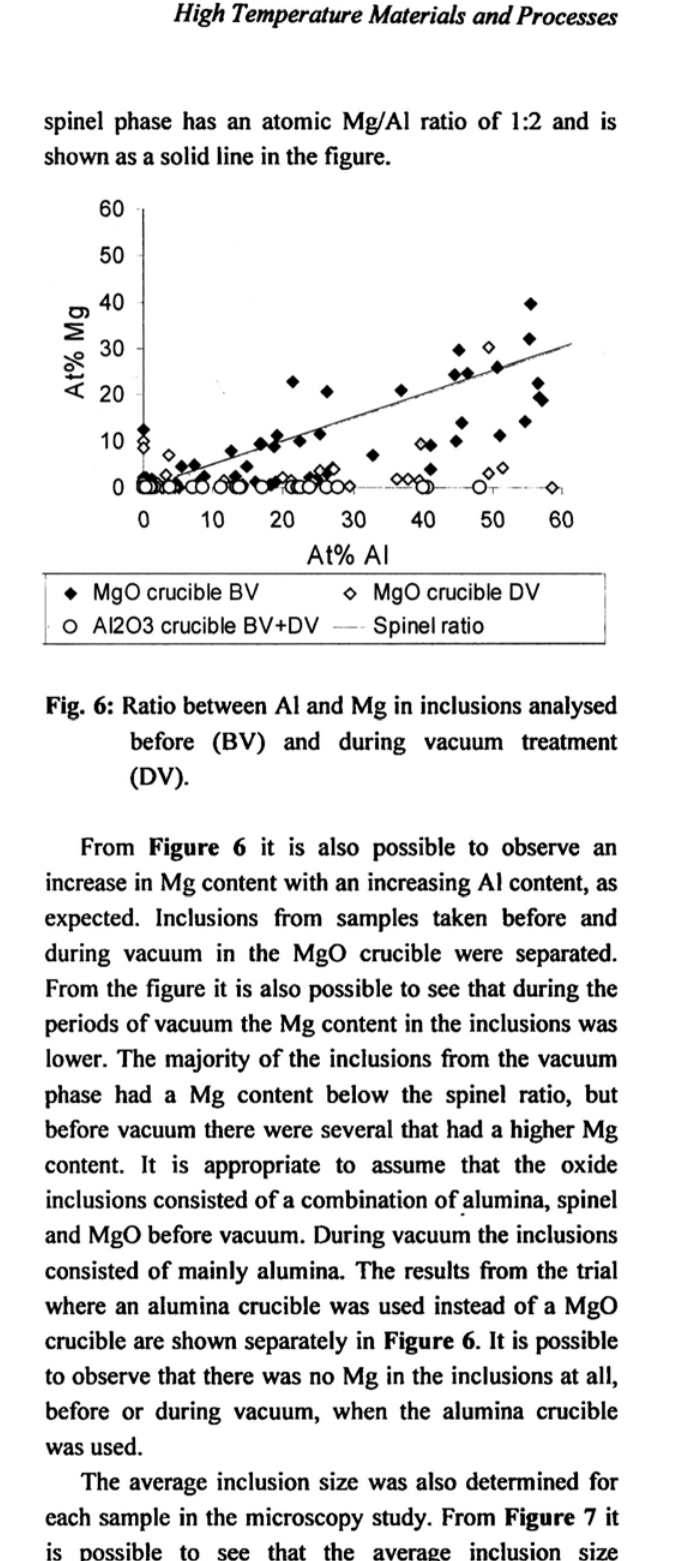
Fig. 5: Composition of all analysed inclusions as a function of the sulphur content in inclusions.